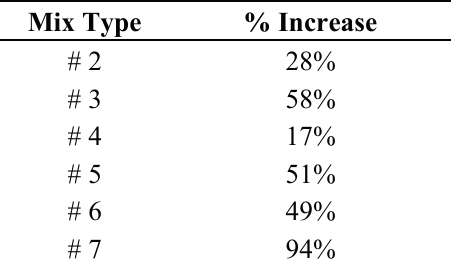
Table 7. Percentage increase in flexural